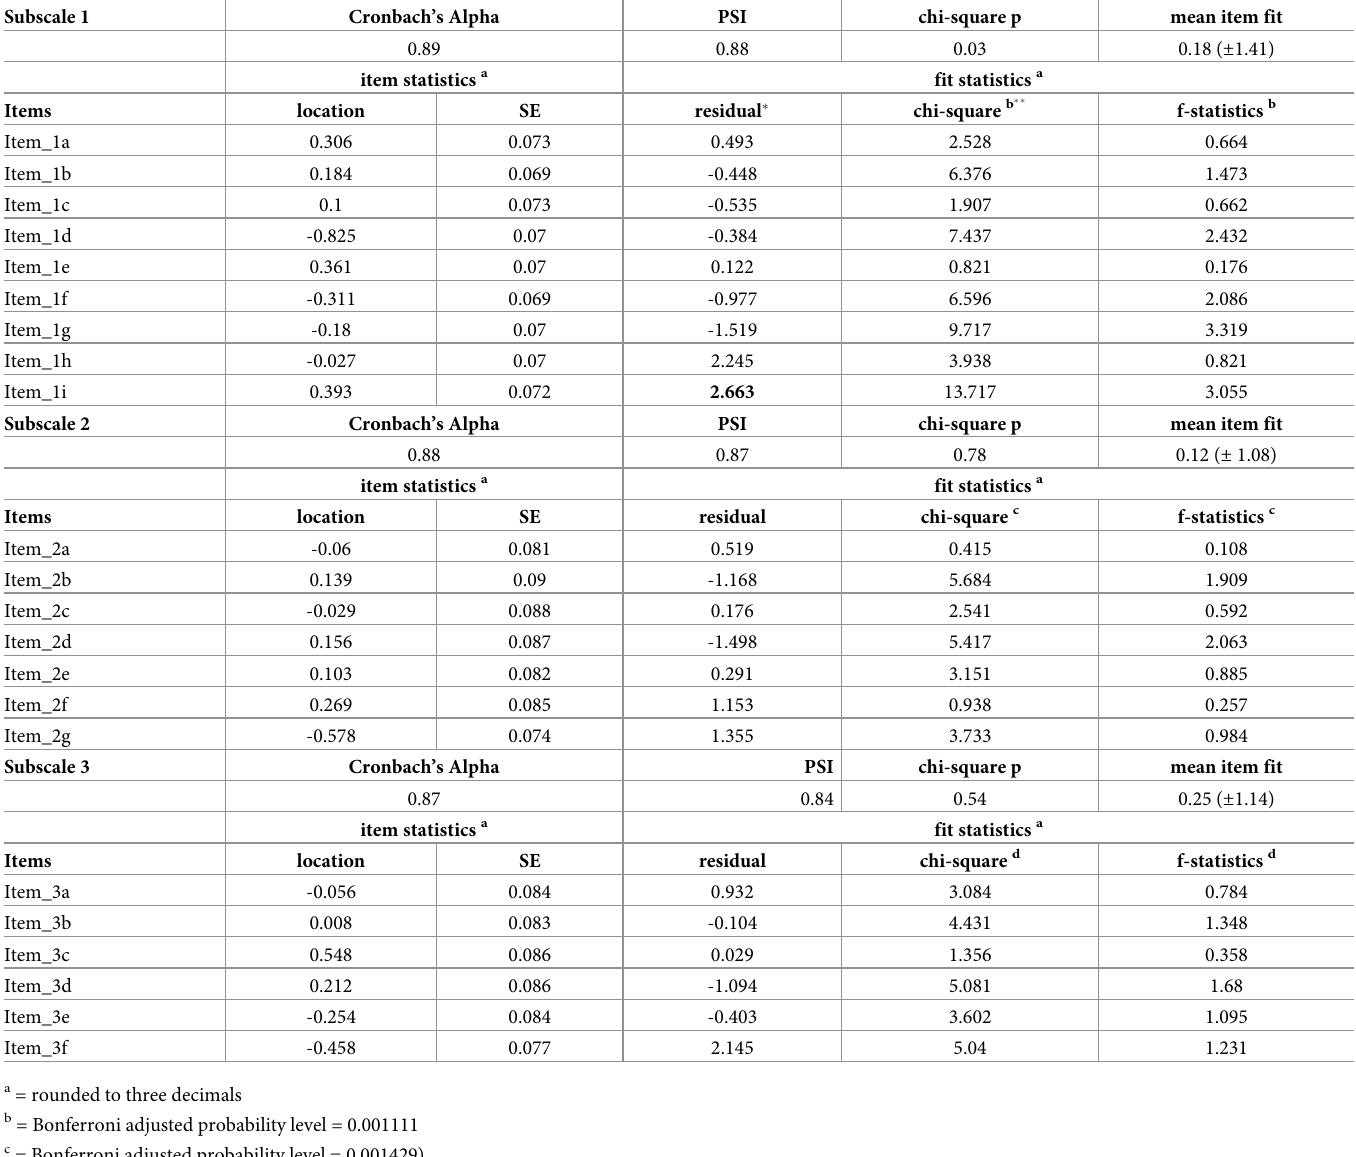
Table 2. Construct validity and internal